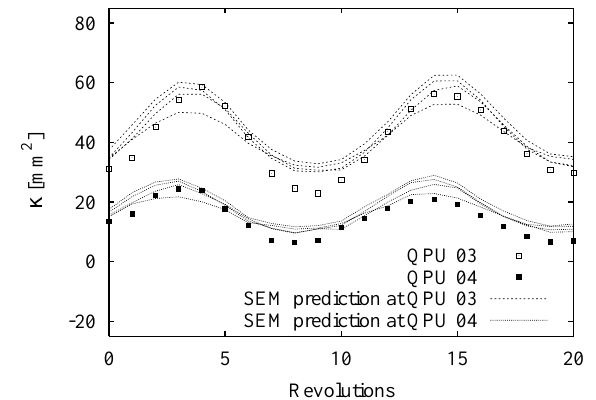
FIG. 6. Filamented emittance of a proton beam measured with quadrupole pickups (QPU) and wire scanner (WS). There is a good agreement. The error bar is the standard deviation for ten measurements. Figure from